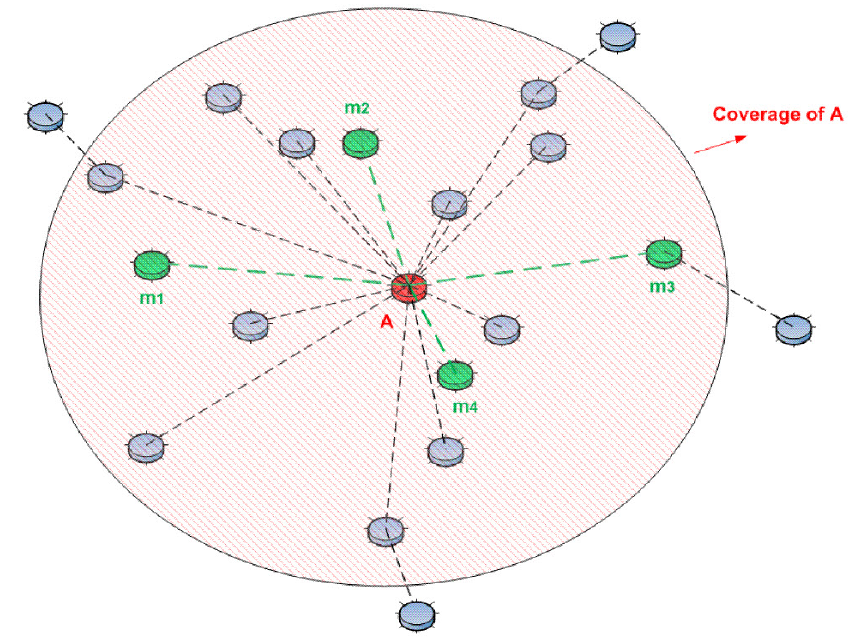
Figure 14. A typical 15-node clustered WSN (one-hop